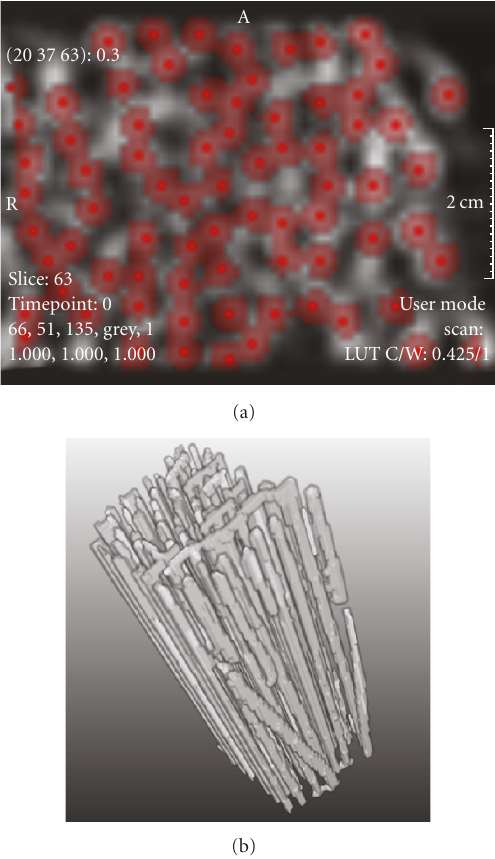
Figure 11: Result of the automatic segmentation algorithm on dataset one. (a) Slice image with the segmentation mask overlaid. (b) 3D view of the extracted fibers. It can be seen that almost all fibers have been segmented accordingly.